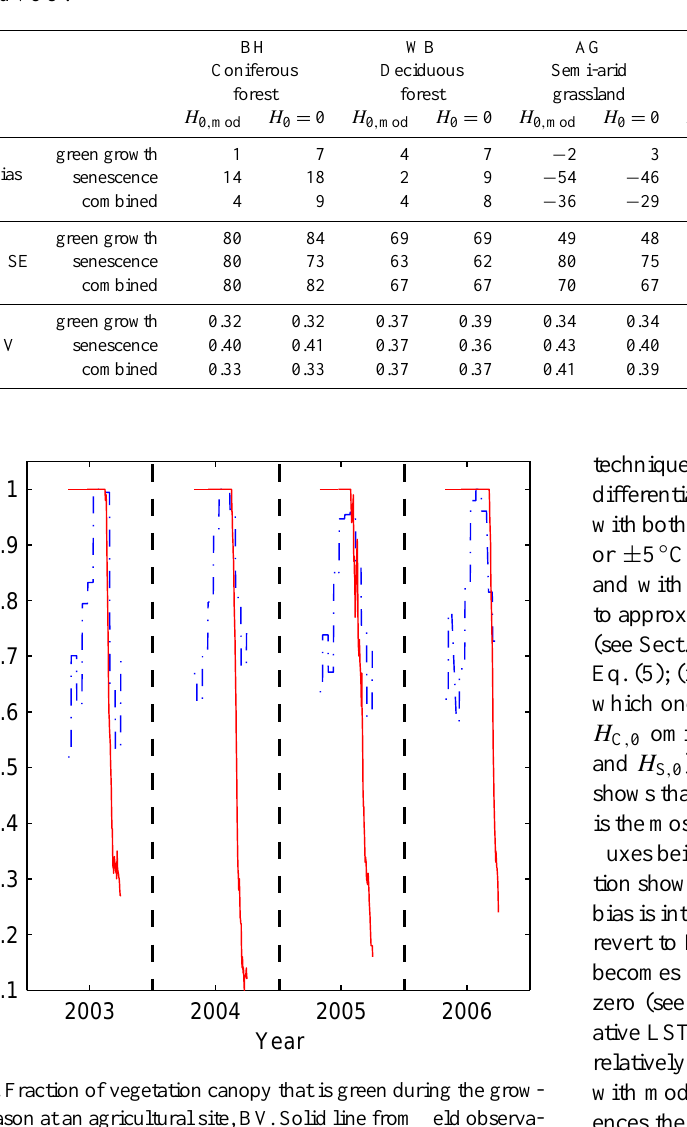
Table 3. Bias (modelled − observed) and RMSE in W m − 2 and CV (unitless) of instantaneous modelled sensible heat flux at noon with the night-time sensible heat flux modelled ( H 0 , mod ) or assumed to be zero ( H 0 = 0). Model runs used t 0 = 01:30LT and were driven primarily by ground-based observations. MODIS products were used to estimate f g , VI at all sites and LAI at VOU. f g , VI = 1 during green growth at BV and VOU.